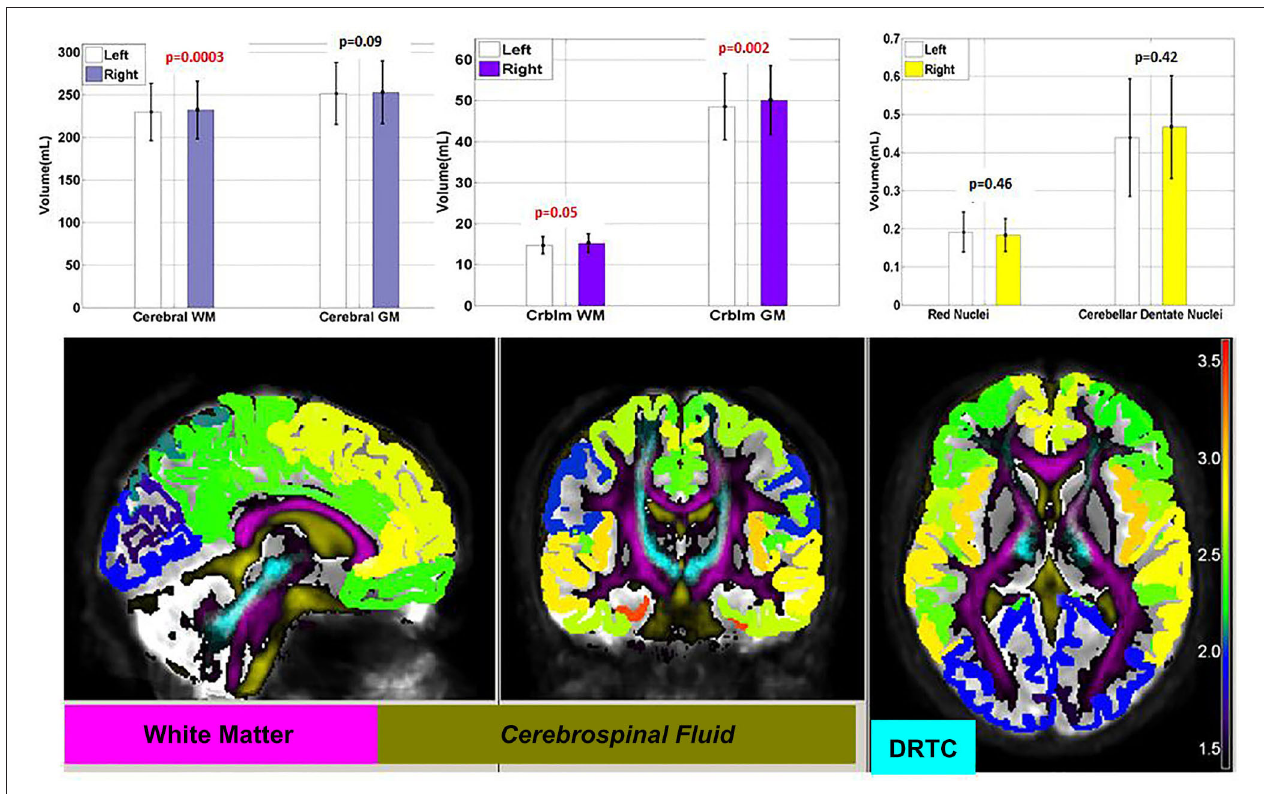
thickness of various part of right and left hemisphere illustrated with the relevant structures such as white matter (WM) (violet), cerebrospinal fluid (CSF) and dentate-rubro-thalamo-cortical tract (DRTC-light blue) The colormap of cortical thickness in mm is shown at the right